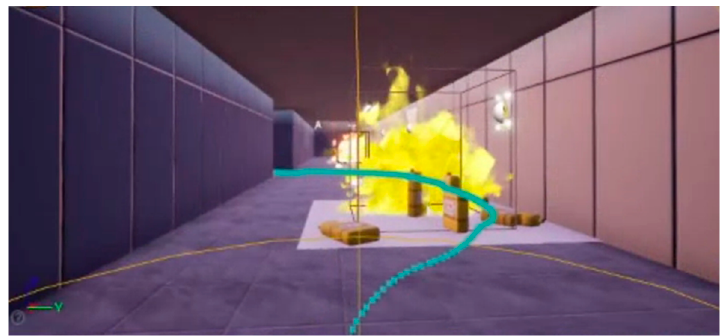
Figure 7. Screenshot of a video recording showing user’s path.